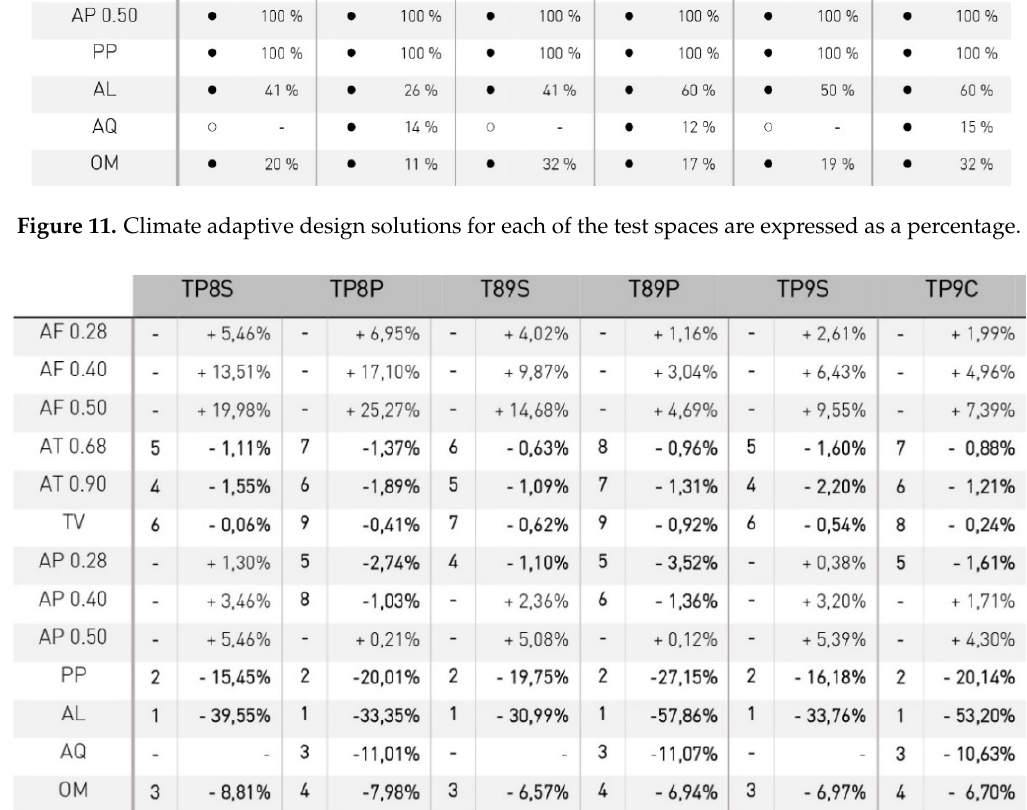
Figure 12. Preferable adopted solutions in test spaces and comfort performances (PMV).